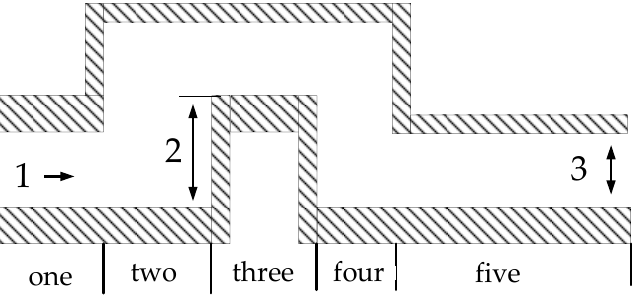
Figure 10. Double ‐ shift line test road diagram. Figure 10. Double-shift line test road diagram.